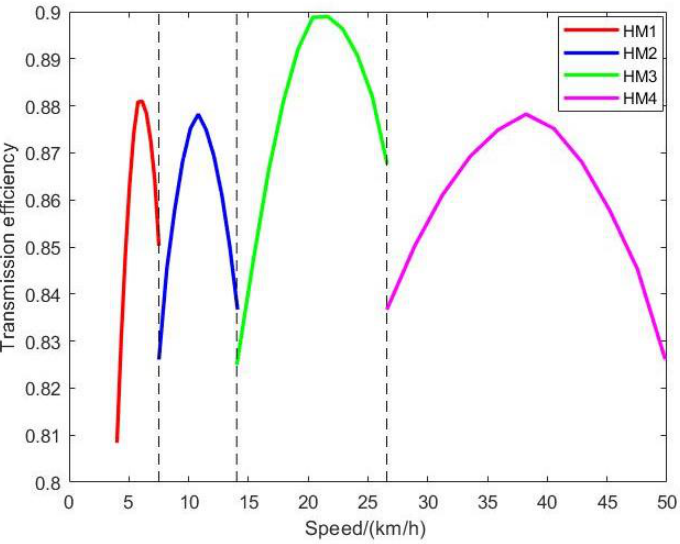
Figure 13. The efficiency of hydraulic – mechanical stages under full load.